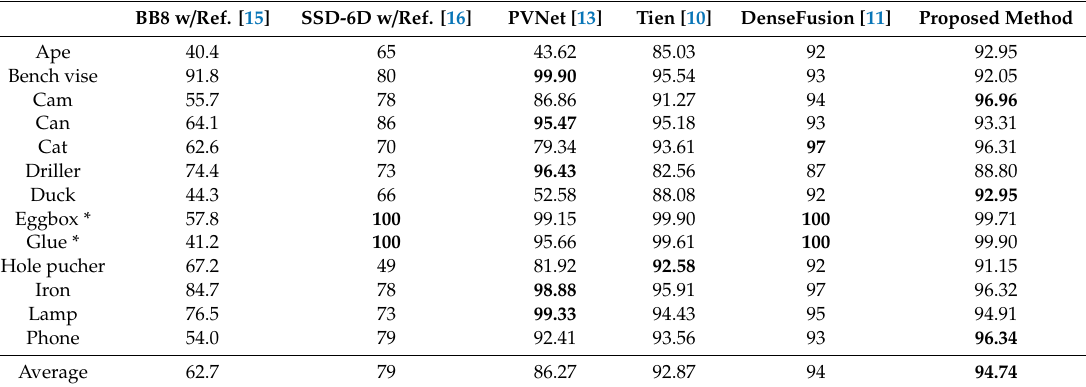
Table 1. Comparison between the proposed method and state-of-the-art approaches on LINEMOD in ADD(-S) metric, where the best results are marked in bold. Note that * denotes the objects are symmetric. BB8 w / Ref. [15]